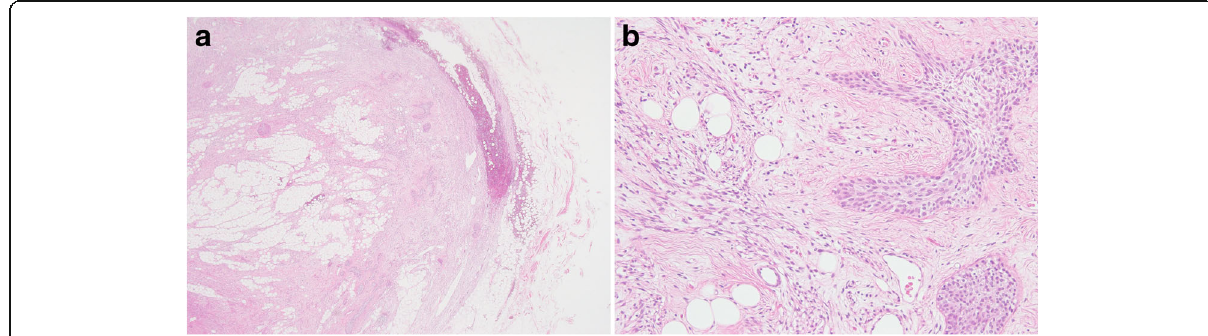
Fig. 3 a , b Histologically, the tumor was composed of an admixture of spindle cells, epithelial nests, and adipose cells (hematoxylin-eosin stain)